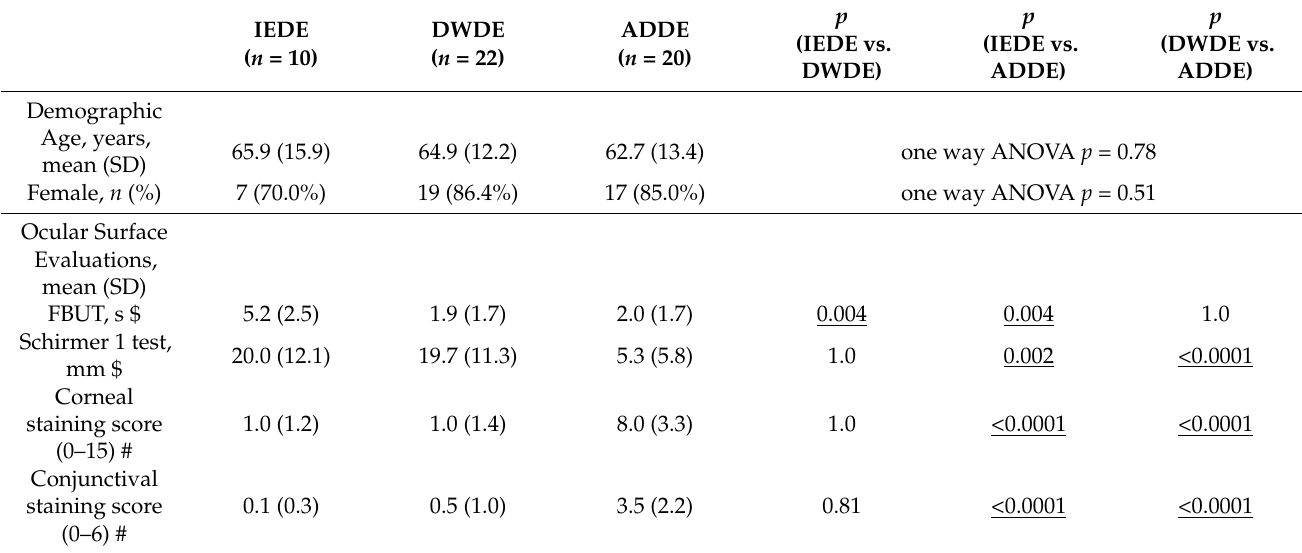
Table 1. Demographic and Clinical Characteristics of Study